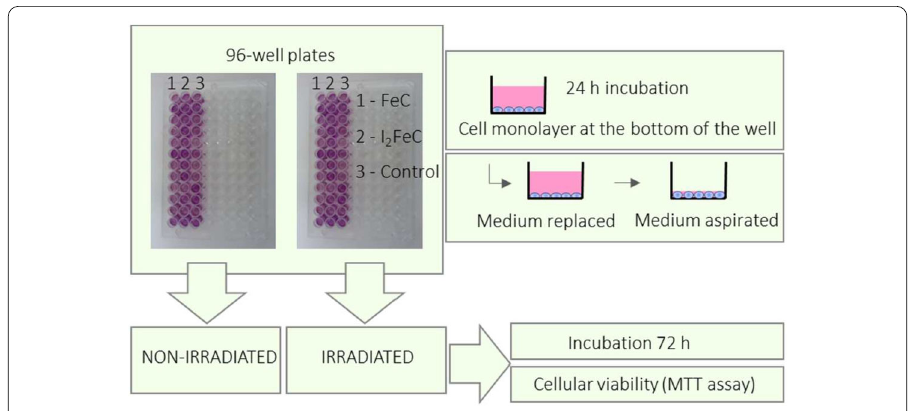
Figure 4 Schematic of the proton irradiation assay